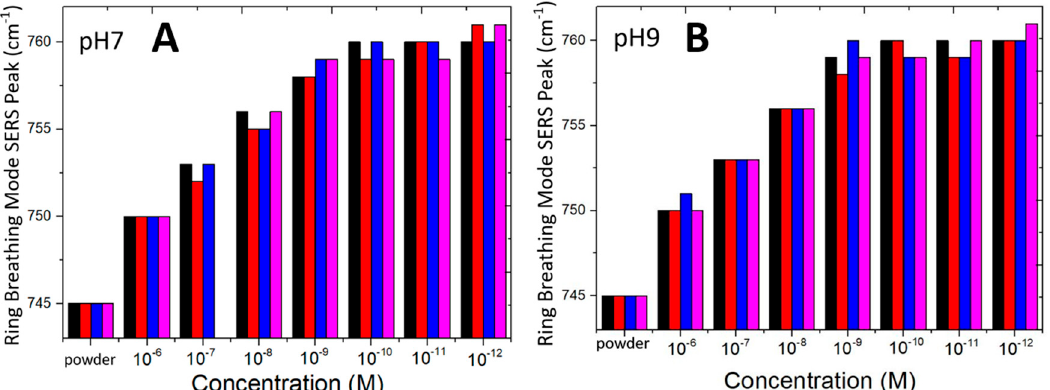
Figure 7. Bar charts of four SERS sensors (displayed in different colors) exhibiting a similar trend of shift of the ring-breathing mode SERS peaks of adenine. Measured SERS peaks of adenine powder on the sensor are also included for comparison. ( A ) pH 7 and ( B ) pH 9 aqueous solution.